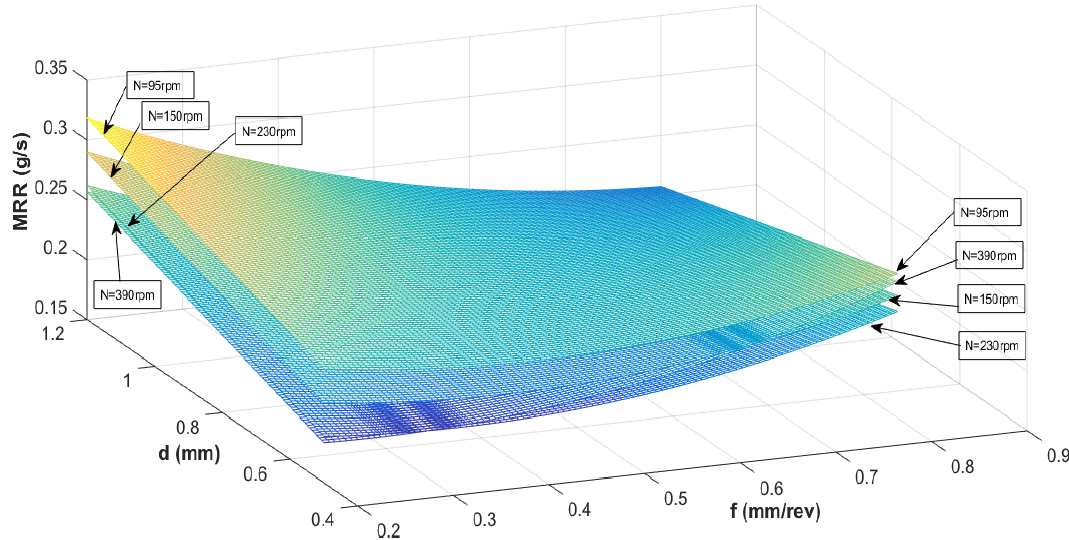
Figure 5. Interaction effect of depth of cut (d) and feed rate (f) on MRR at different spindles.